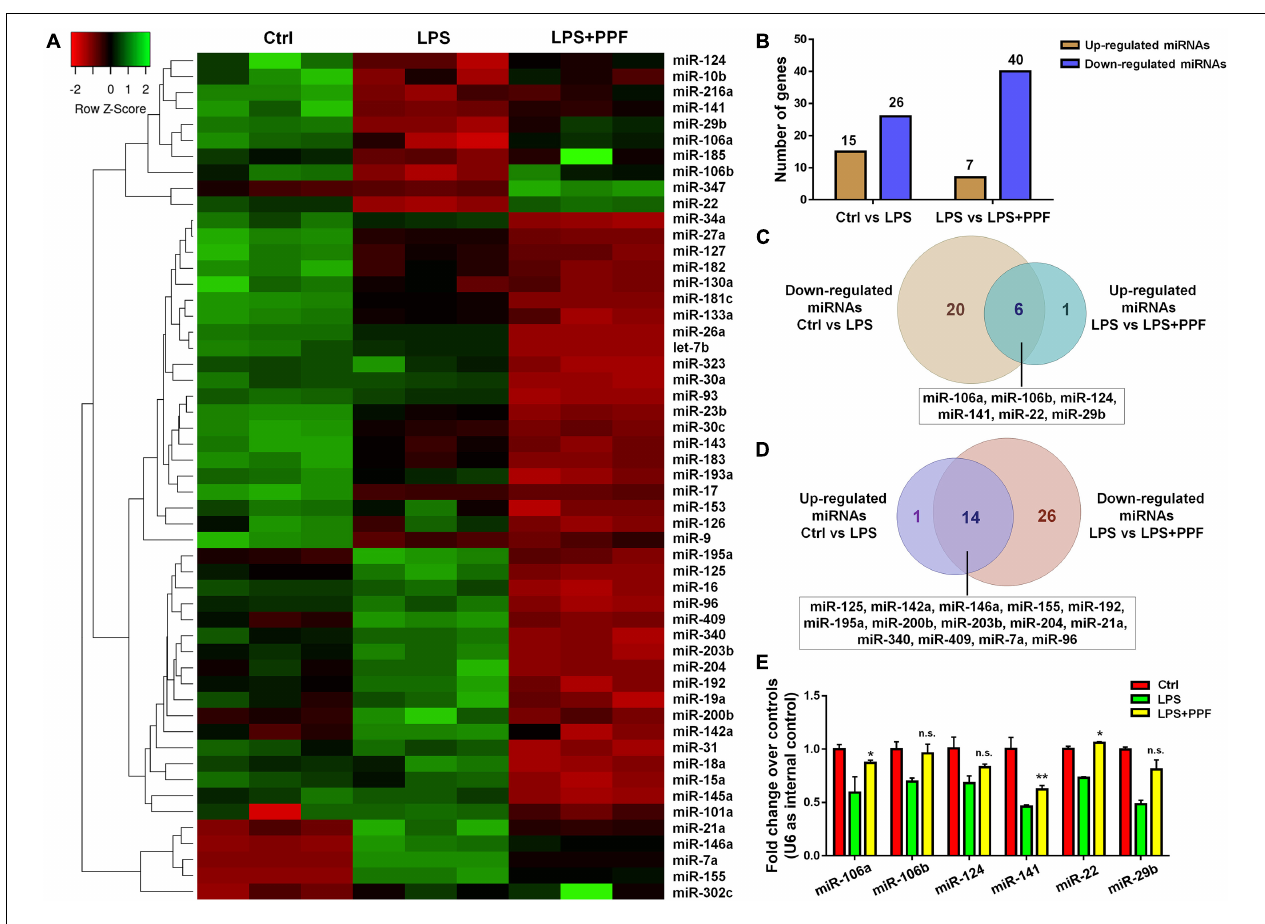
FIGURE 2 | APP-EXO promote APP expression in recipient cells. (A) Hierarchical cluster analysis of 53 miRNAs expressed in microglia with LPS and propofol treatment. (B) The numbers of up- and down-regulated miRNAs in comparison between either LPS and control groups or LPS + PPF and LPS groups. (C) Venn diagram represents the numbers of down-regulated (light brown) miRNAs in LPS group in comparison with control group and up-regulated (light blue) miRNAs in LPS + PPF group in comparison with LPS group. (D) Venn diagram represents the numbers of up-regulated (lavender) miRNAs in LPS group in comparison with control group and down-regulated (light pink) miRNAs in LPS + PPF group in comparison with LPS group. (E) The expression levels of miR-106a, miR-106b, miR-124, miR-141, miR-22, and miR-29b in microglia with LPS and propofol treatment were determined by qRT-PCR. Data were represented as mean ± SD from three independent experiments. The symbols * and ** denote p < 0.05 and p < 0.01, respectively, in comparison with control group. n.s. denotes